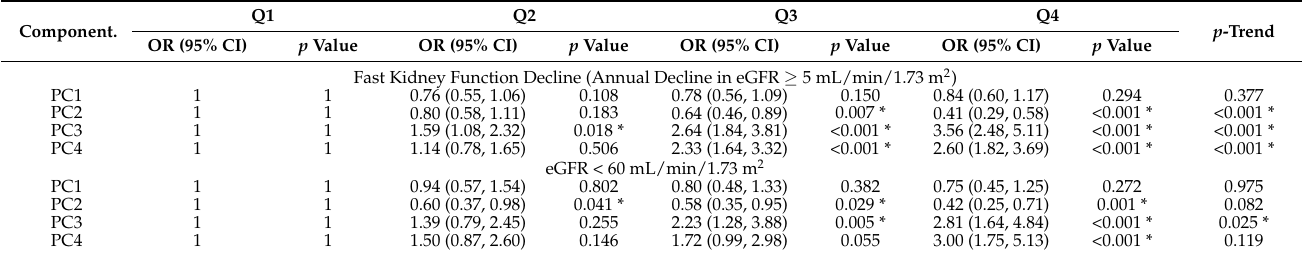
Table 4. Adjusted ORs (95% CI) of swift renal function disorder and eGFR < 60 mL/min/1.73 m 2 with an increase between the quartiles of each metal’s exposure pattern.